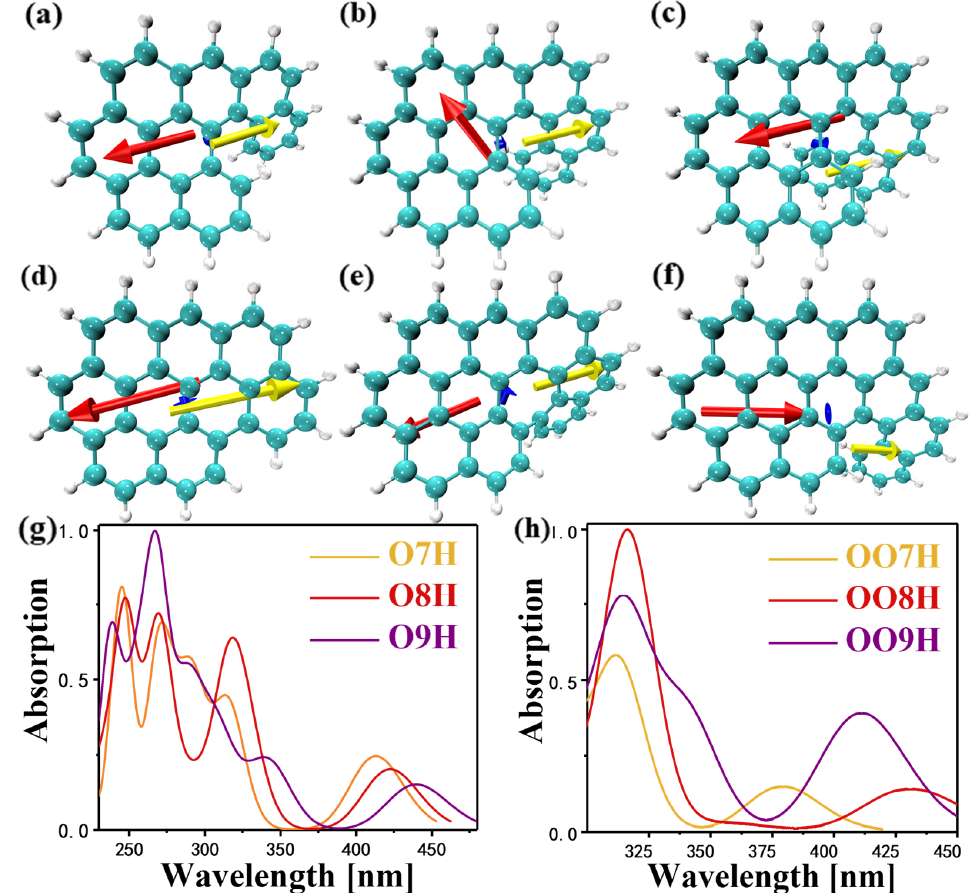
Figure 1. The pattern of dipole moments corresponding to 6 molecules under normalized conditions: ( a ) O7H, ( b ) O8H, ( c ) O9H, ( d ) OO7H, ( e ) OO8H, and ( f ) OO9H. The blue arrow is the direction of the overall dipole moment, the red arrow is the direction of the dipole moment of the benzopyrene fragment, and the yellow arrow is the direction of the dipole moment of the remaining helicene fragments. Comparison of the ultraviolet–visible absorption spectroscopy (UV–Vis) absorption spectra of molecules, ( g ): O7H, O8H, and O9H. ( h ): OO7H, OO8H, and